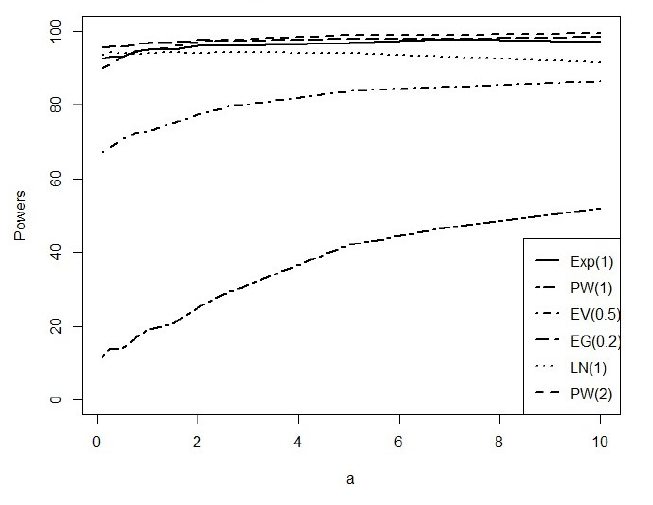
Figure 2. Estimated powers for R 100, a for some alternatives appearing in Table